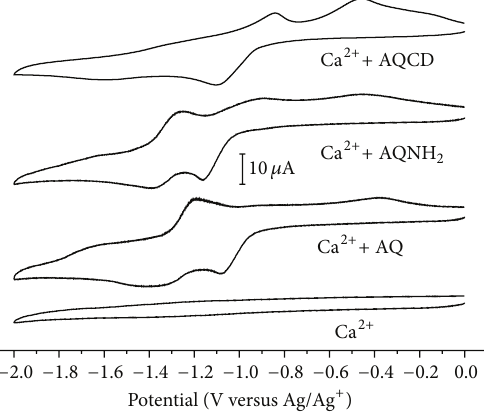
Figure 5: CVs of 0.75 mM Ca 2+ in the absence and the presence of 0.5 mM AQ, AQNH 2 , and AQCD in 0.1M TBAPF 6 /CH 3 CN. Scan rate: